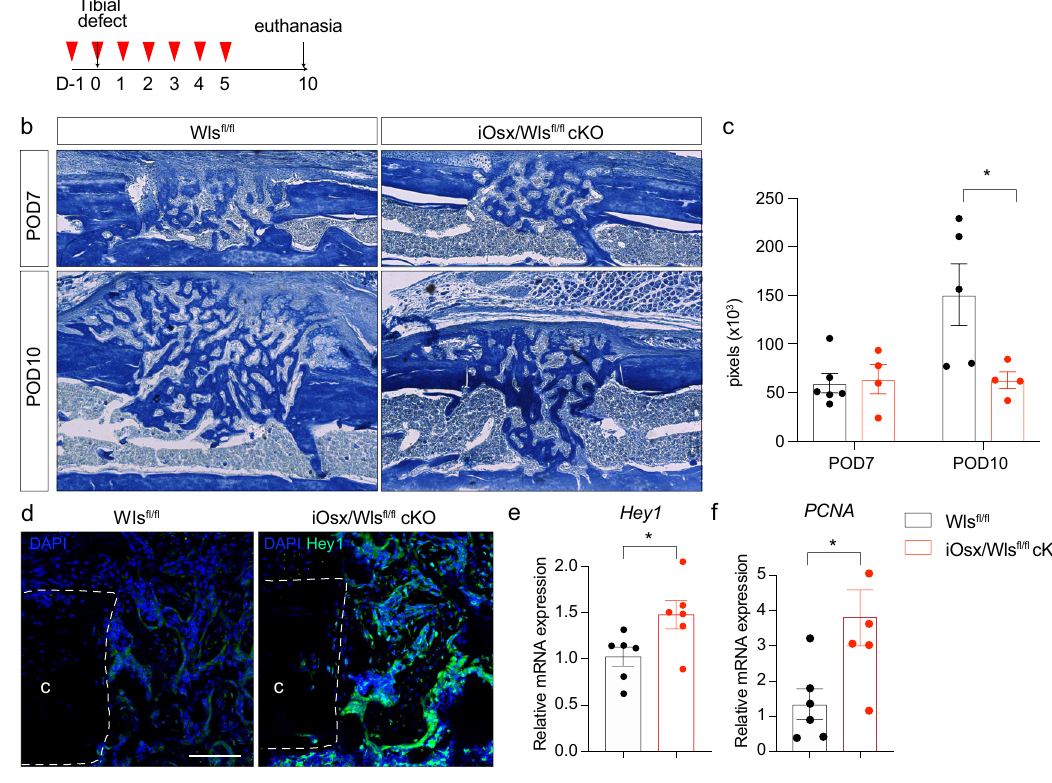
Fig. 5 Wnt deletion in osx -lineage cells prolongs Notch responsiveness and associated proliferation. a Experimental scheme using iOsx/ Wls fl / fl cKO mice. Red arrow head indicates tamoxifen i.p. injection (1 mg/day), gray arrow denotes day of tibial defect surgery and day of euthanasia. b Aniline Blue staining of tibial defect sites at POD7 and POD10 in control and iOsx/Wls fl / fl cKO mice. c Histomorphometry of bone volume in callus of control and iOsx/Wls fl / fl cKO mice. d Increased and prolonged Notch responsiveness in iOsx/Wls fl / fl cKO mice shown by IF against Hey1 and e Hey1 gene expression. f PCNA expression revealed increased proliferation in the injury sites of iOsx/Wls fl / fl cKO mice. Scale bar = 50 μ m. n = 6. d Pcna expression at day 10 indicates a prolonged proliferative phase up to day 10 in the presence of decreased Wnt signaling. * p < 0.05. c cortical bone. Data were represented as mean ± s.e.m.